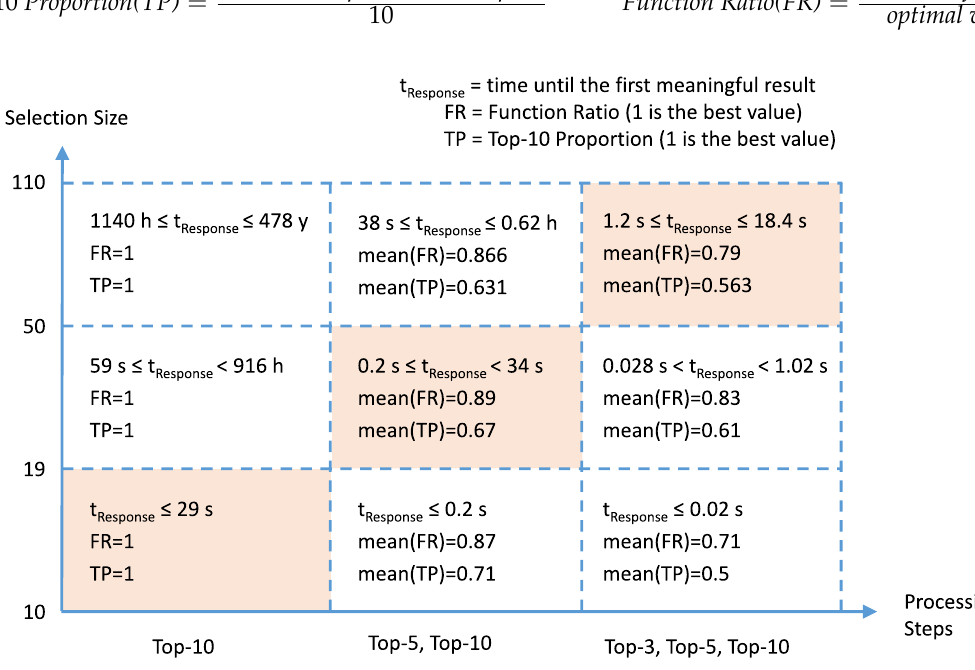
Figure 5. Exploring different PVA configurations of chunking data and process. The y axis represents the provinces selection size, ranging from 10 to 110 provinces; the x axis represents the process, ranging from (1) a monolithic process computing ( n splitting the selection in 2 chunks to produce an early partial result, and then compute ( n chunk in a longer time, to (3) a process composed by the sequence of computations ( n the selections in 3 chunks and producing an early partial result, refining it using two chunks, and then computing the optimal solution on the whole selection. The t Response values report the time span needed to produce the first meaningful result for each configuration. The confidence measures, TP and FR indicate the means of the numerical ratio between the estimated function and the optimal one, and the proportion of the provinces belonging to both the estimation and the optimum, respectively. The orange tiles represent the selected strategies in the current implementation: they respect the time constraints and minimize